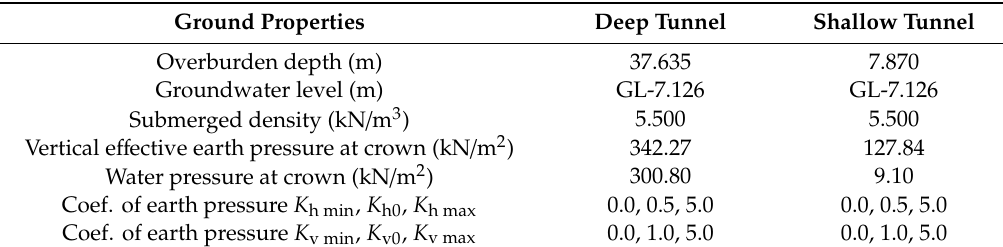
Table 4. Tunnel position and ground properties.